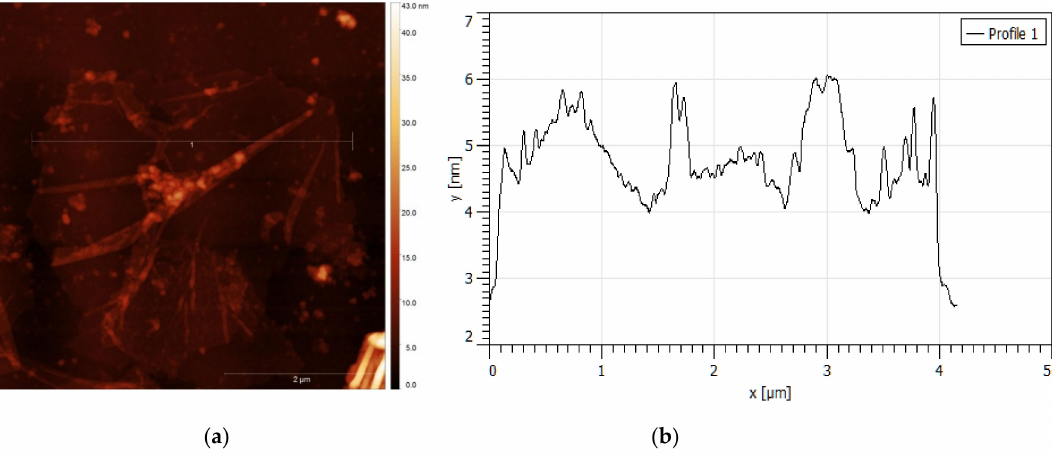
Figure 10. ( a ) AFM images of layered HGO nanosheets on SiO 2 with ( b ) corresponding height